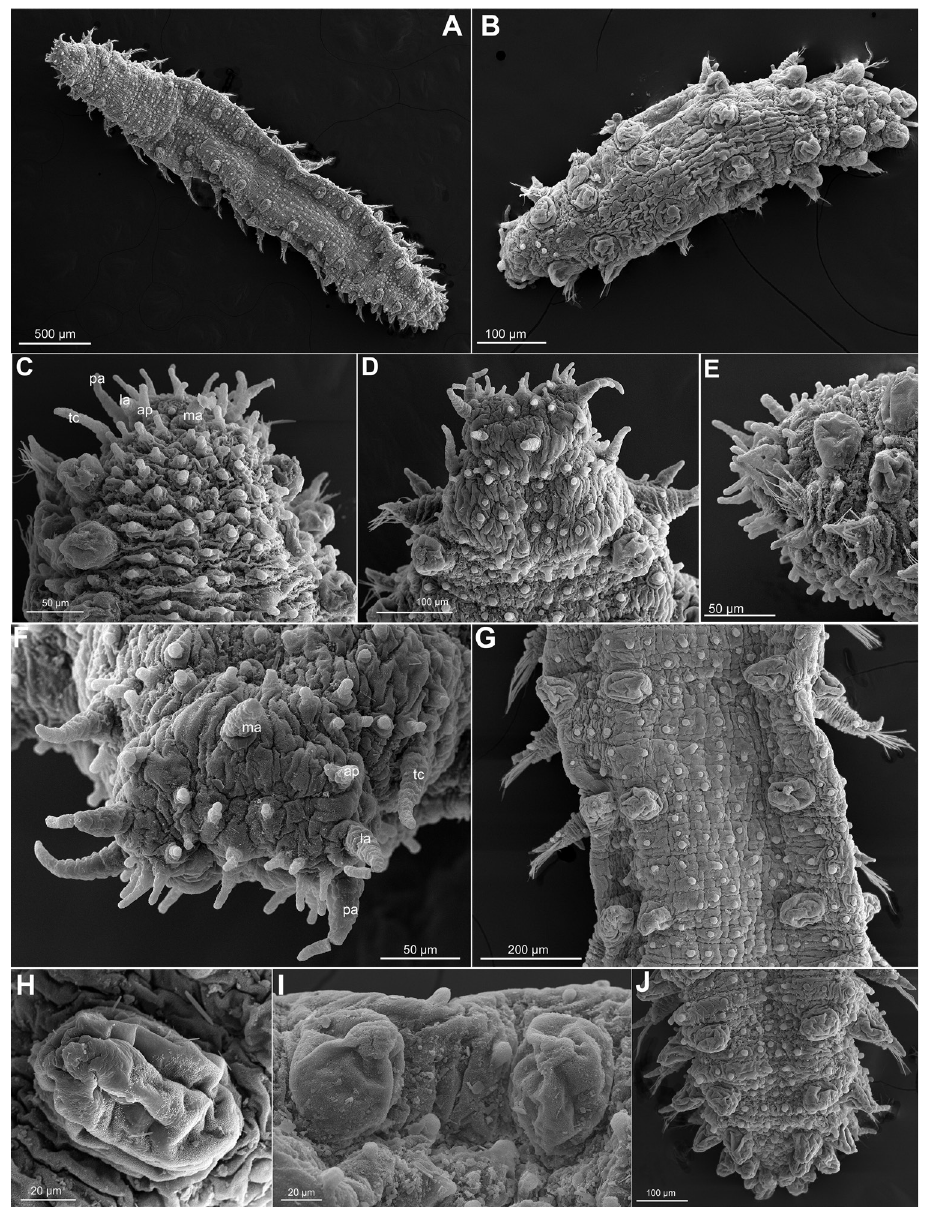
Figure 8. Sphaerodoropsis corrugata , USNM 1002193 and 1002207. A Whole specimen, dorsal view B Juvenile, dorsal view C, D Anterior end, dorsal view E Same, side view F Head, frontal view G Mid- body segments, dorsal view H, I Mid-body dorsal macrotubercles J Posterior segments and pygidium, dorsal view. Abbreviations: la, lateral antenna; ma, median antenna; pa, palp; tc, tentacular